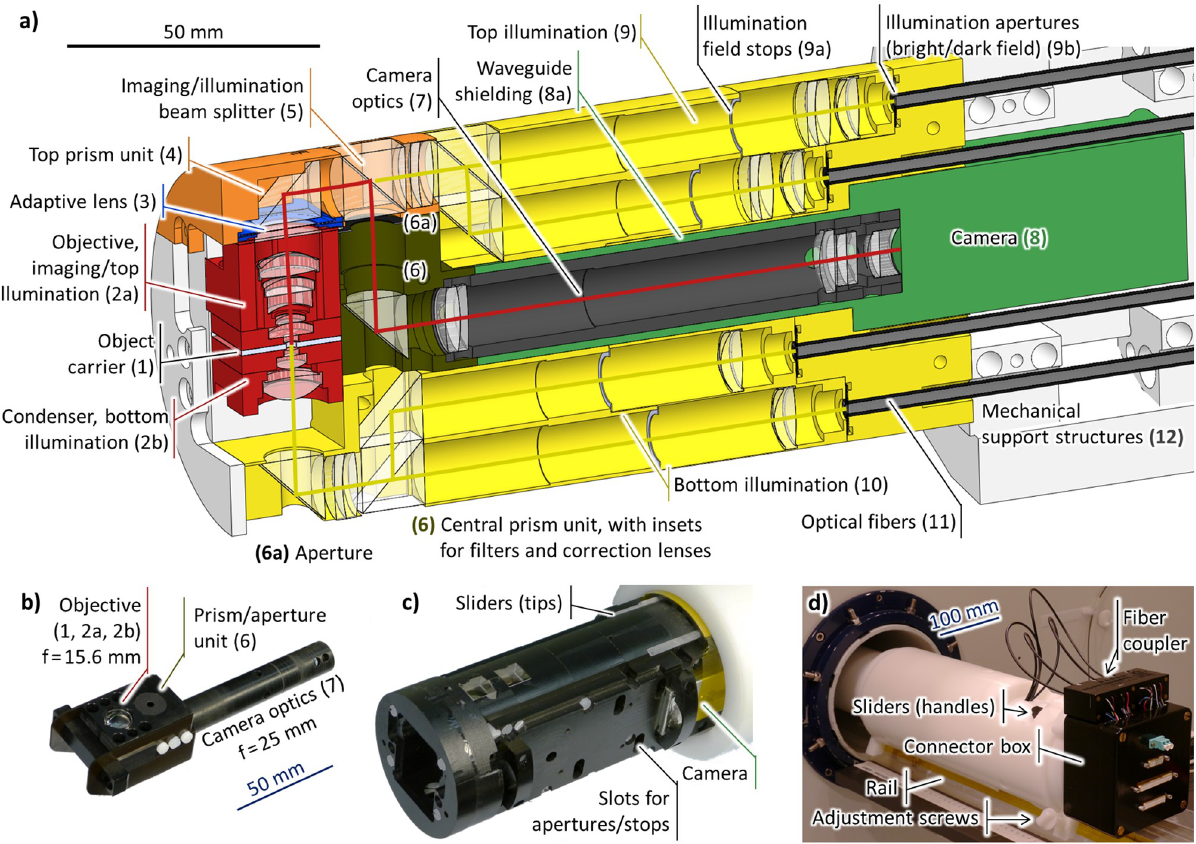
Fig 1. a) Color-coded cross section of the final design of the microscope. Not all lenses and apertures are to scale. The red line indicates the imaging light path and the yellow lines indicate the different illumination light paths. b) Photo of the assembled objective/prism unit/camera optics, consisting of parts (1), (2a), (2b), (6) and (7). c) Front part of the microscope. d) Rear part of the microscope when placed inside the